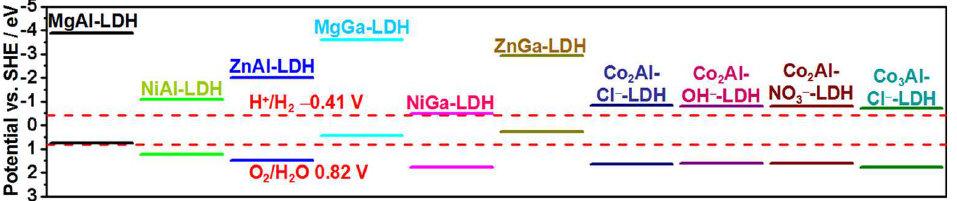
Figure 2. The position of M II M III −LDHs band edge [41]. Copyright 2015 American Chemical Soci- ety.